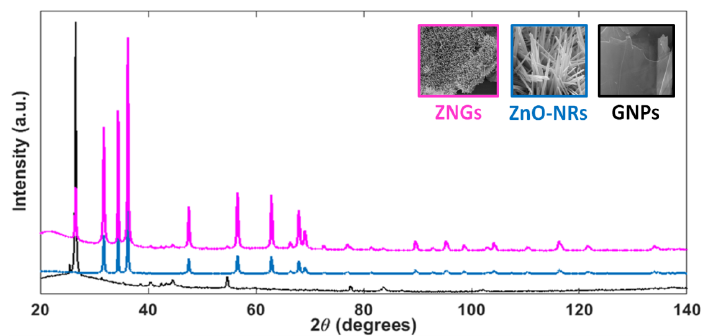
Figure 3. X-ray diffraction patterns of all the produced nanostructures.